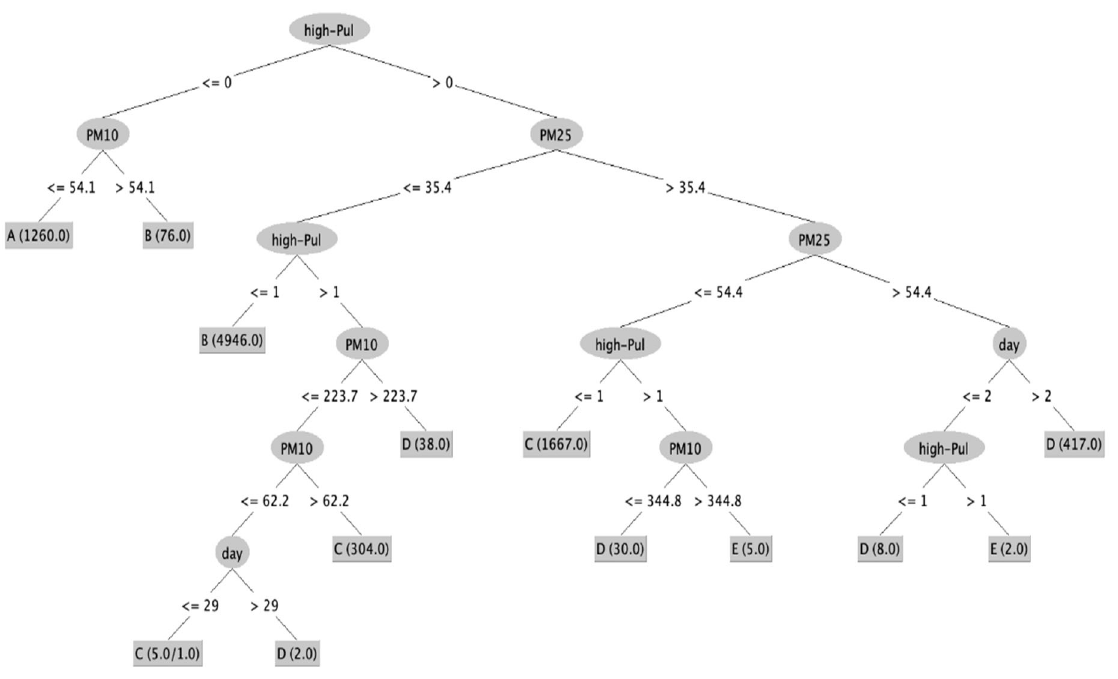
Figure 3. Tree of Mailiao dataset (selected variables) by DT.